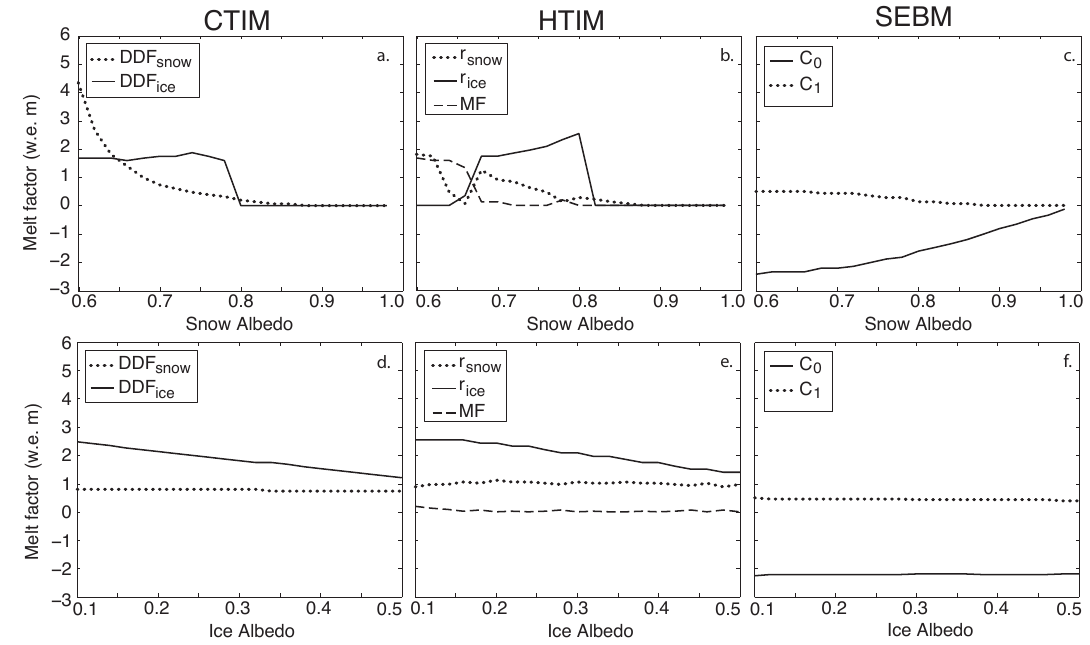
Fig. 5. Melt-model parameter sensitivity to snow (first row) and ice (second row) albedo.